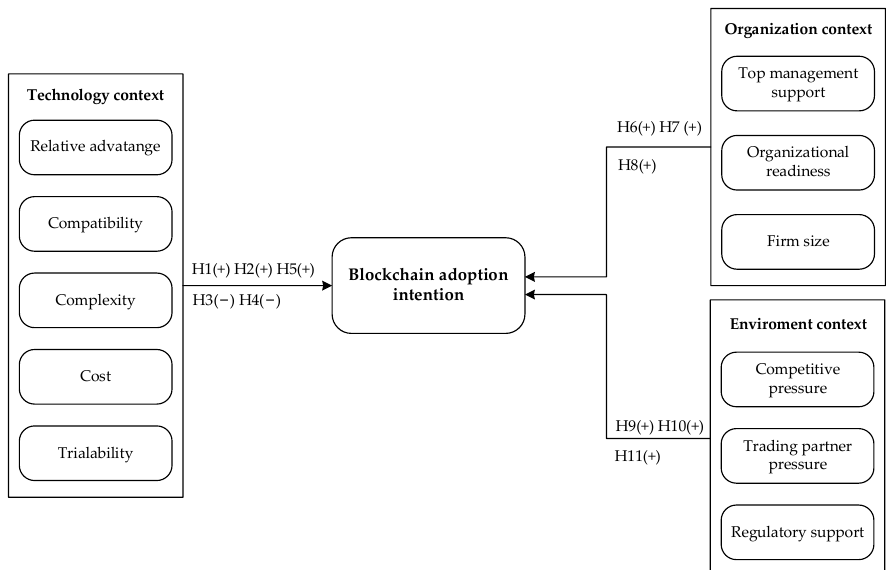
Figure 1. Research model of intention to adopt blockchain technology based on the TOE framework.